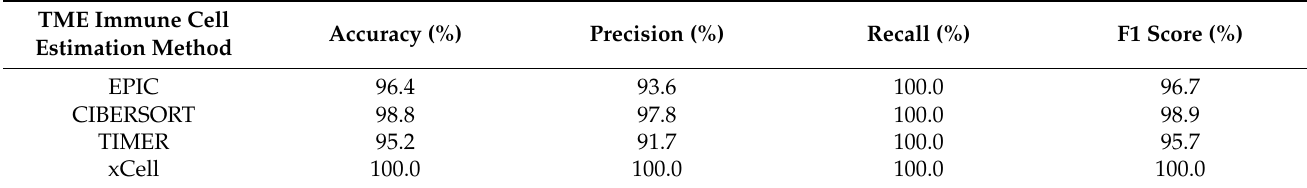
Table 1. Statistical validation of the predictive accuracies of the AI